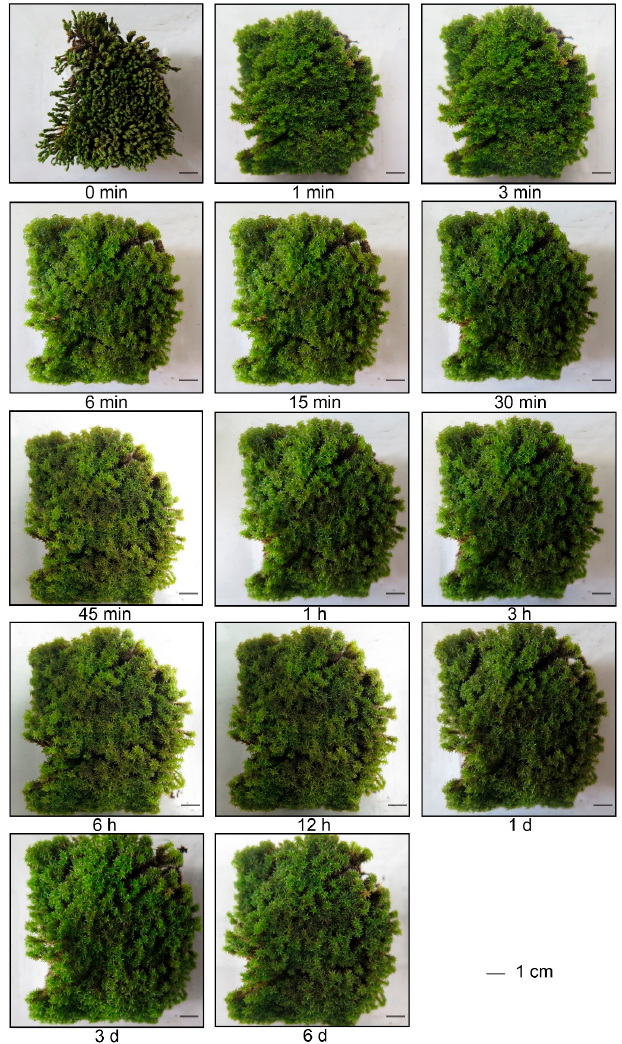
Figure 1. Morphological changes of desiccated Racomitrium canescens ( R. canescens ) in the rehydra- tion processes.